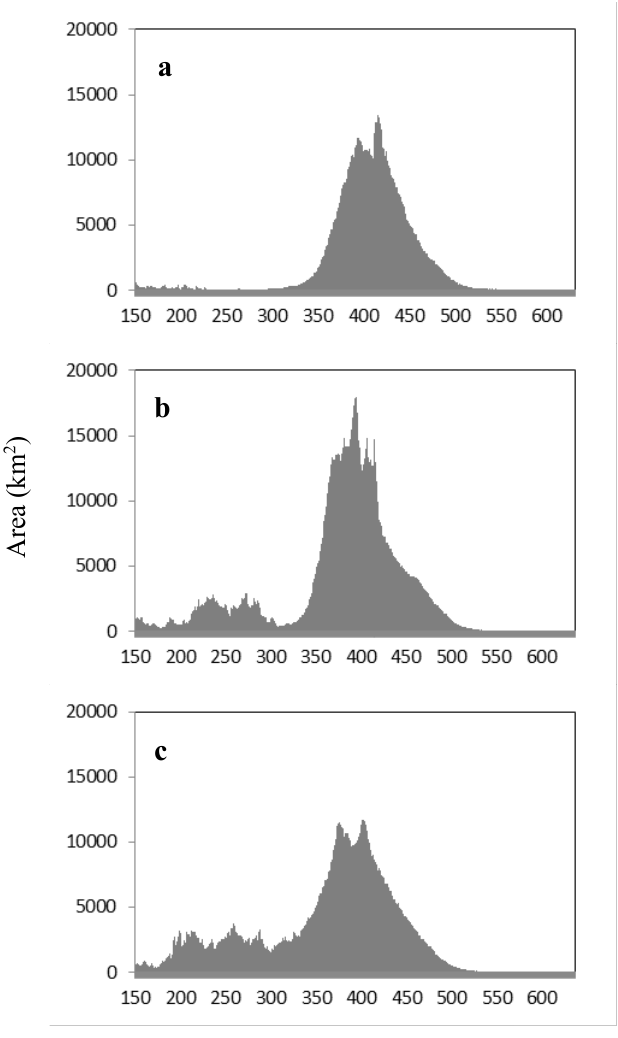
Figure 8. Histograms of predicted volume (m 3 /ha) with areas (km 2 ) under climate projections; ( a ) current (baseline); ( b ) A1B projection; ( c ) A2